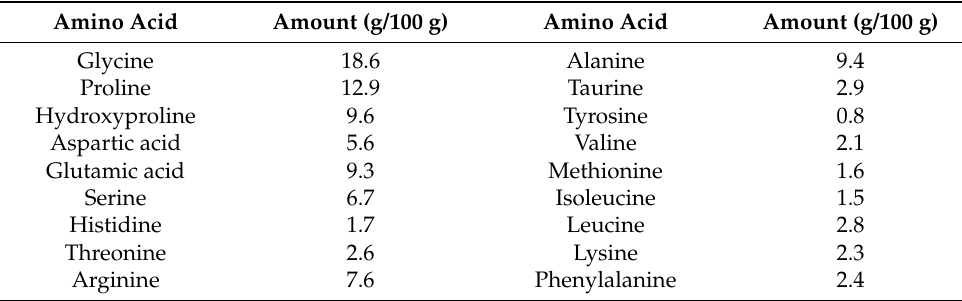
Sodium alginate (SA) from brown algae (A2033, Sigma, Gillingham, United Kingdom) was used. The molecular mass distribution of the sodium alginate sample was determined by HPLC (Table 2). An LC-20A chromatograph equipped with an RID-10A refractive index detector (Shimadzu Corp., Kyoto, Japan) and Shodex Asahipak GS-520 HQ and GS-620 HQ (7.5 mm × 300 mm) columns was used. Columns were calibrated using standard pullulans with M w s of 6.2 to 740 kDa (P-82 kit, Showa-Denko, Japan) and blue